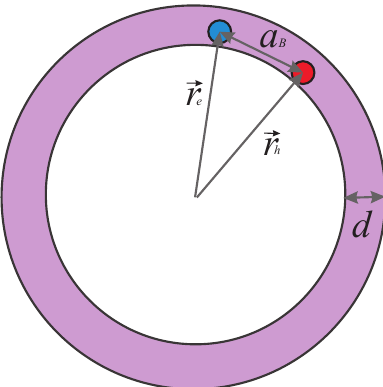
Figure 1. The sketch of an exciton localized in a single quantum ring of the width d . In the case of a narrow ring d (cid:28) | (cid:126) r e , h | , the exciton state can be treated as quasi one-dimensional. Here, a B denotes Bohr radius of an